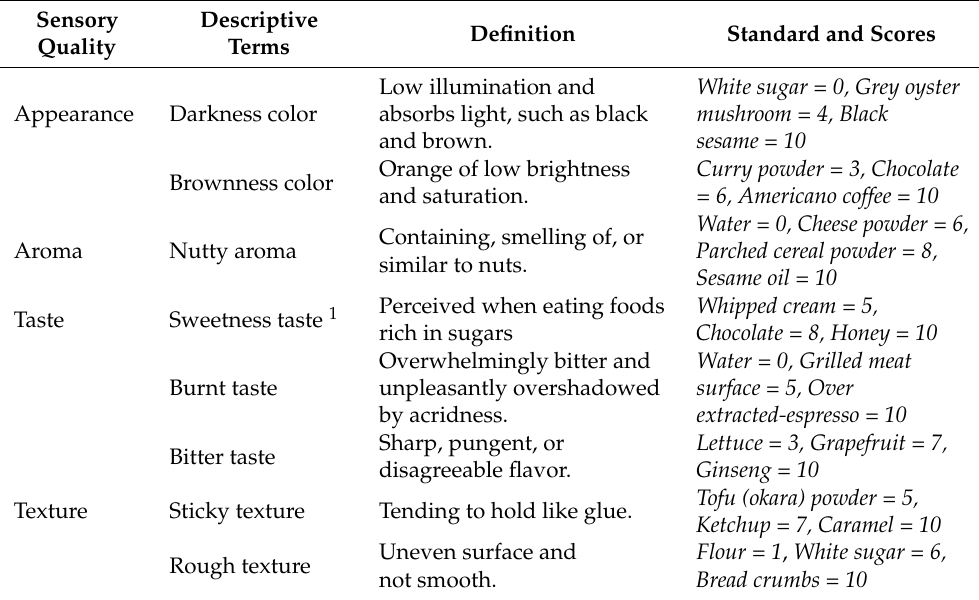
Table 2. The glossary of standards and their scores, defining the quality characteristics used in the sensory